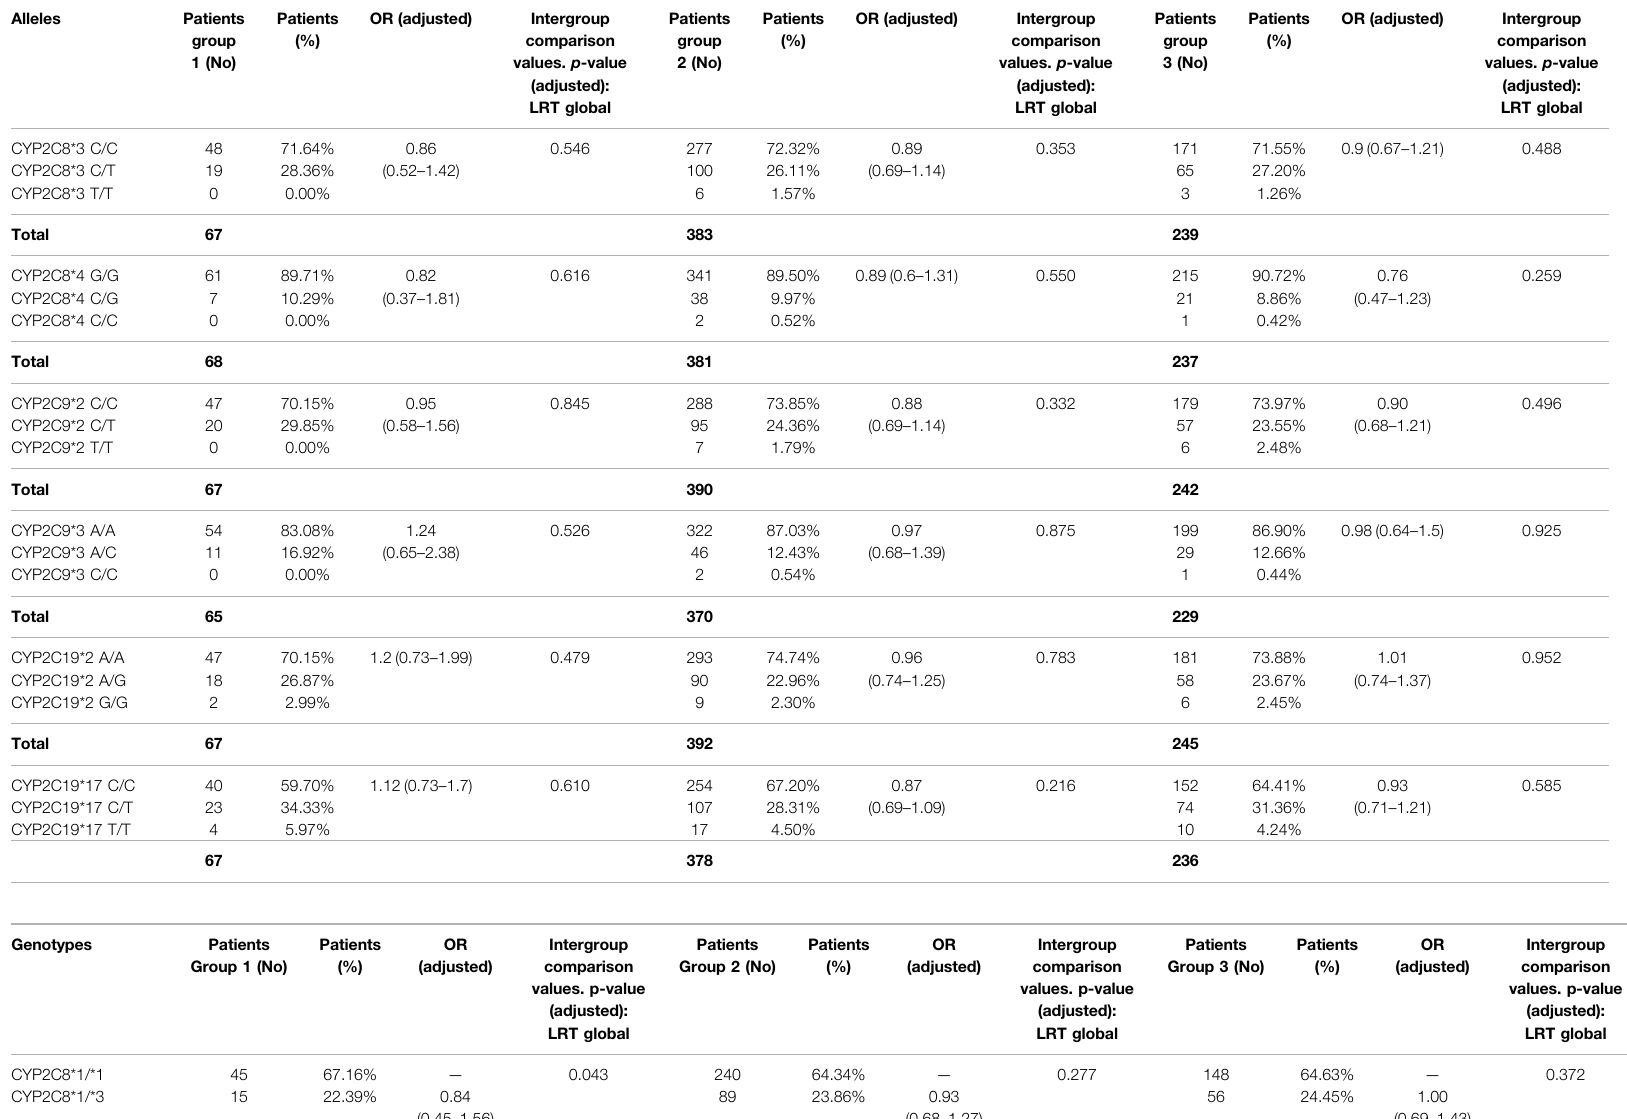
TABLE 5 | Alleles, genotypes and inferred phenotypes observed in the three subgroups of patients. Alleles Patients group